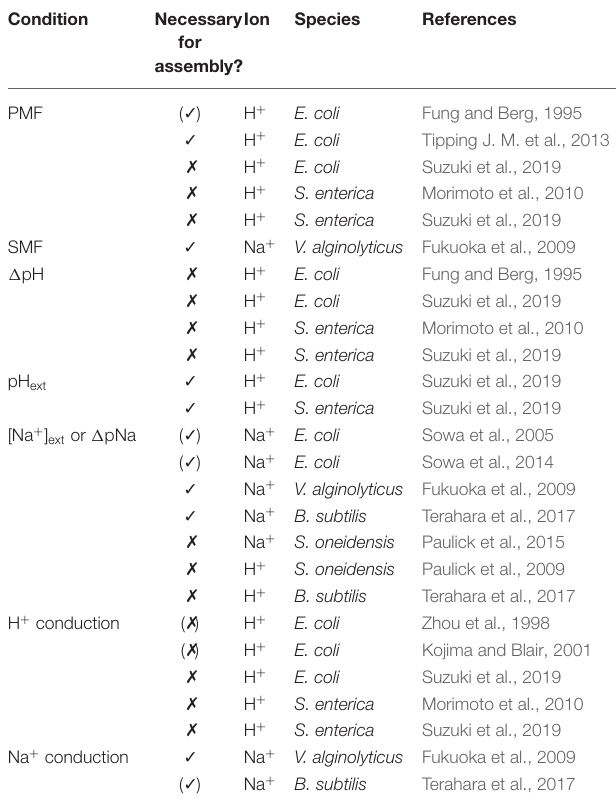
TABLE 2 | Ion motive force (IMF) and ion related conditions shown to be necessary, 3 , or not, 7 , for stator assembly.